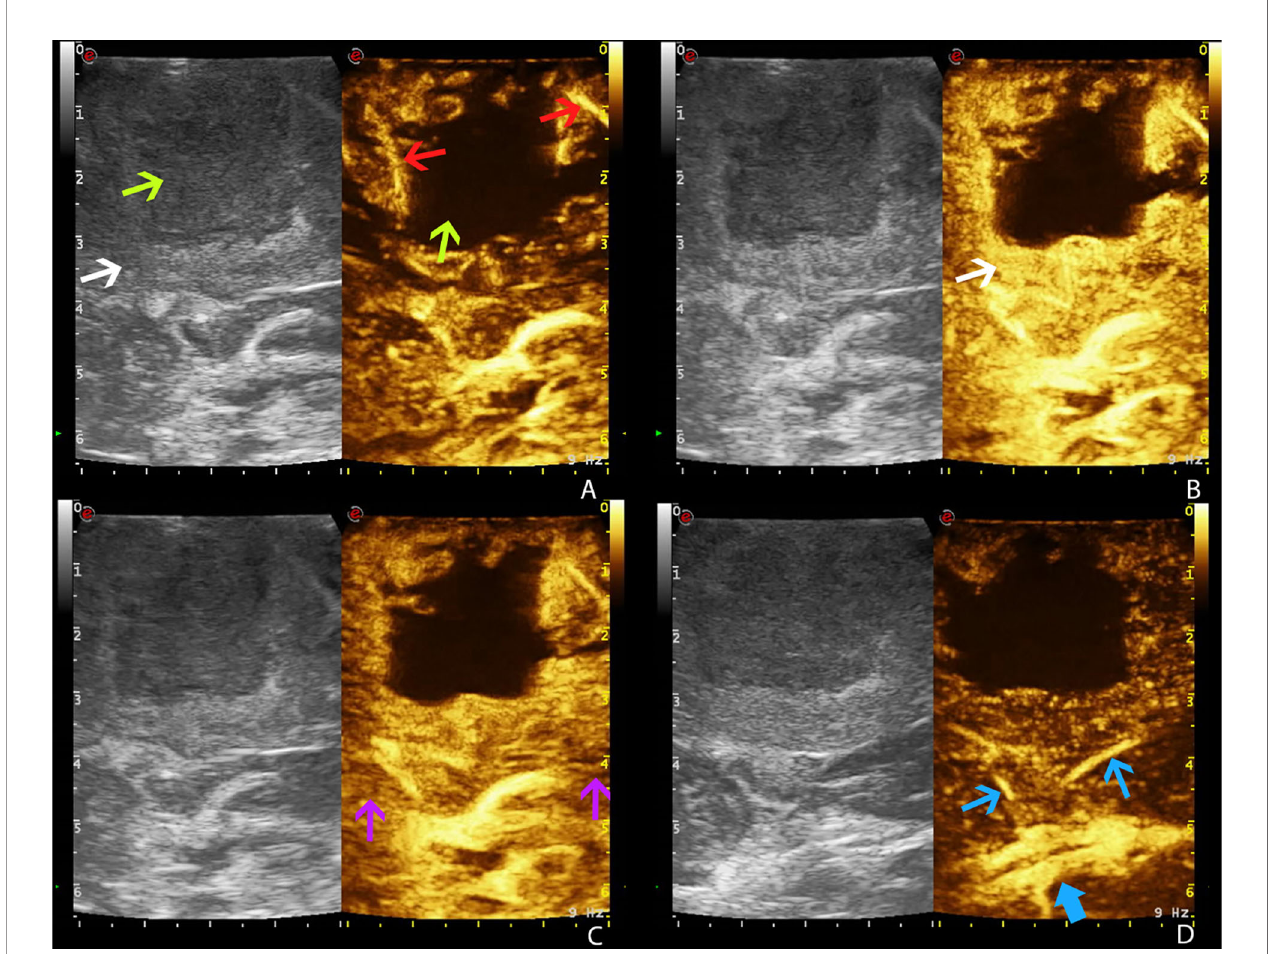
FIGURE 2 | Time frame of GBM visualization by CEUS (case no. 3) (dual frame visualization: B-mode imaging on the left, contrast-enhanced ultrasound imaging on the right). Gas- fi lled microbubble contrast agent allows to visualize the different phases of intravascular contrast-enhancement thus visualizing the tumor angioarchitecture. (A) Arterial phase. (B) CE peak. (C) Parenchymal phase. (D) Venous phase. White arrow: GBM. Green arrows: necrotic core of GBM. Red arrows: GBM arterial supply. Purple arrows: normal brain parenchyma. Blue arrow: GBM venous drainage (blue thick arrow: internal cerebral